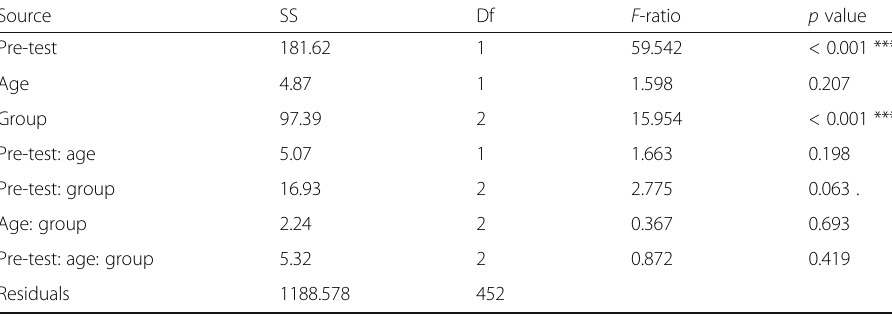
Table 17 Analysis of covariance (ANCOVA) type II SS results for Material 3 Source SS Df